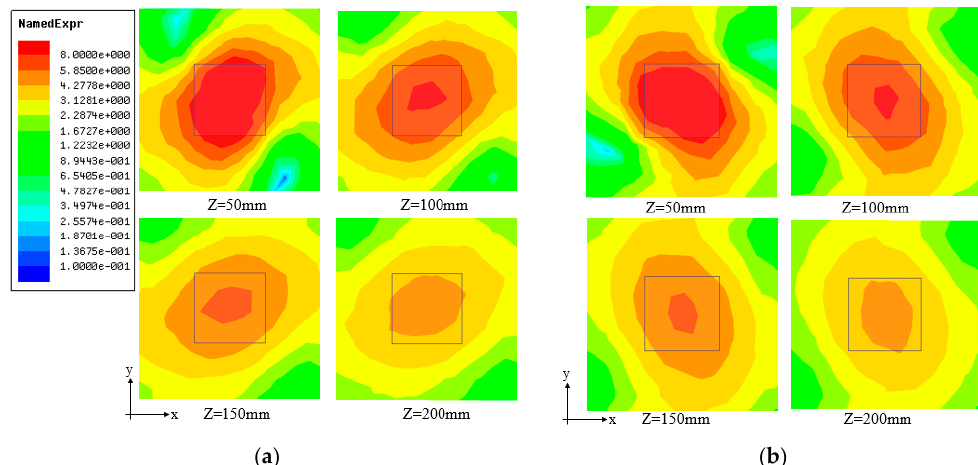
Figure 16. Distribution of simulated electric field components (Ex, Ey) at different heights when loop spacing d = 5 mm: ( a ) Ex distribution and ( b ) Ey distribution.